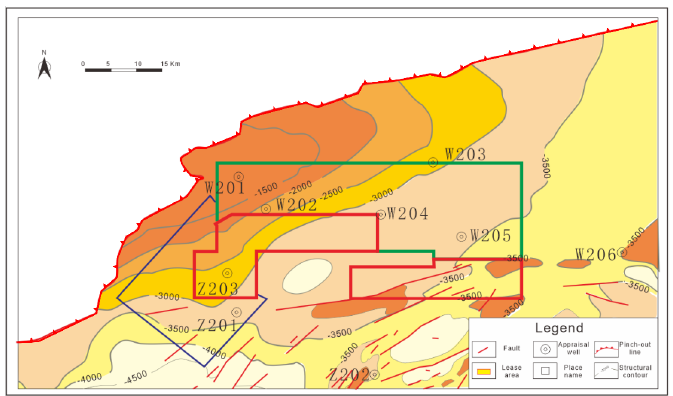
Figure 1. Structural map of the Weiyuan shale gas field.